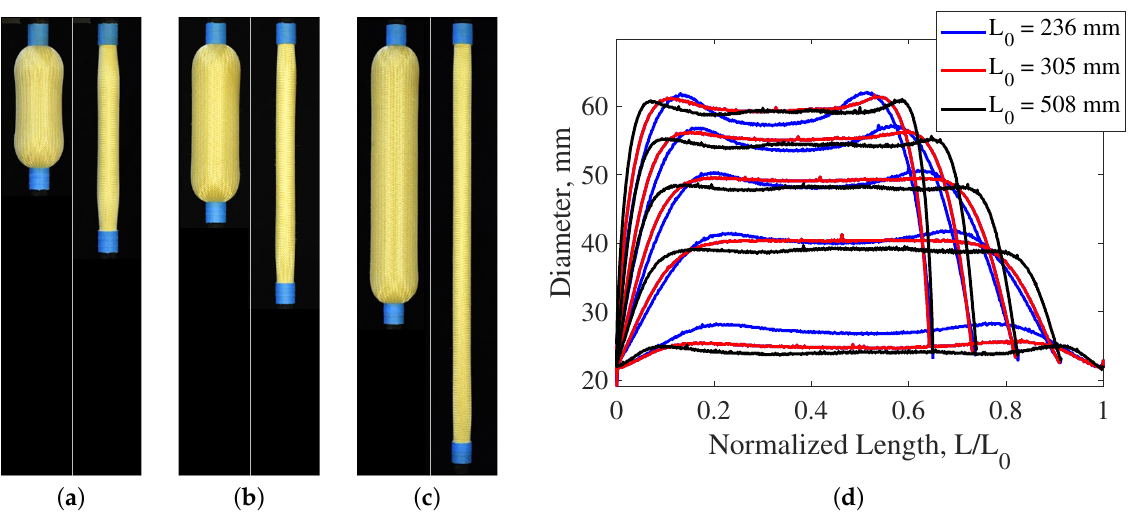
Figure 17. Shape profile comparison for PAMs of different lengths: ( a ) L 0 = 236 mm. ( b ) L 0 = 305 mm. ( c ) L 0 = 508 mm. ( d ) Comparison of their shape profiles at 0, 8.75, 17.5, 26.25, and 35 percent contraction (689 kPa (100 psi)). The profiles have approximately equivalent diameters with slight differences in shape.